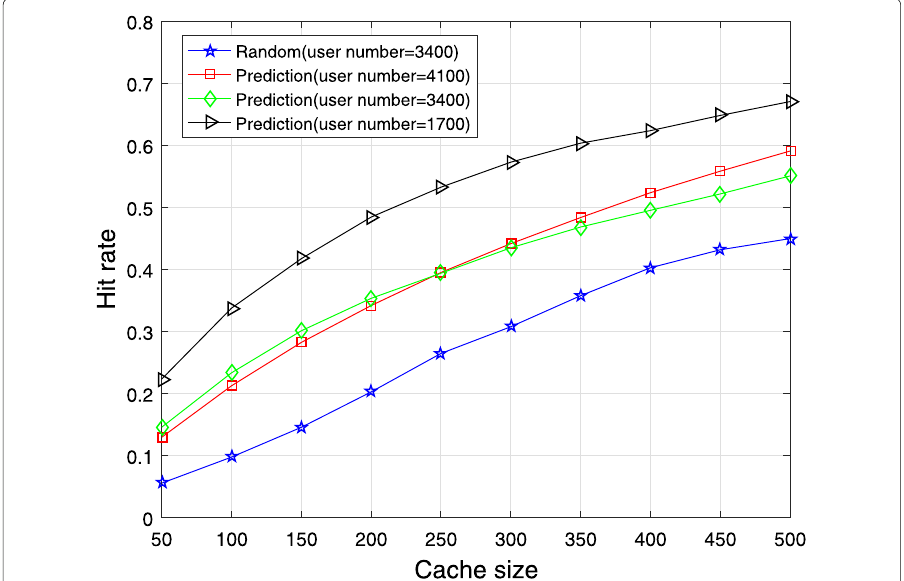
Fig. 5 Cache hit rate versus cache size of the